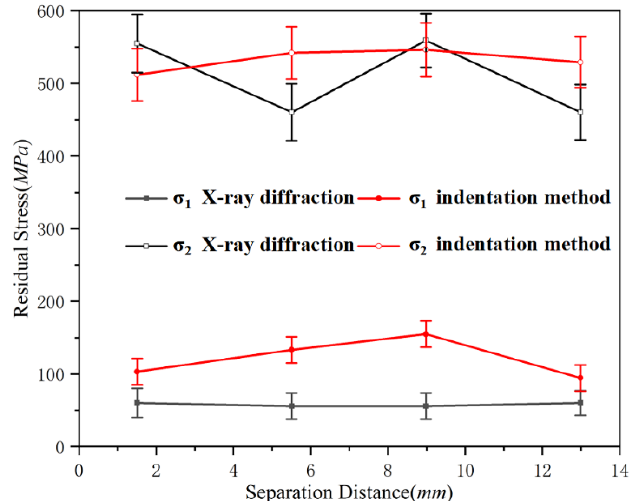
Figure 7. Measurement of Residual Stress in Inconel718 Weld Zone by X-ray Diffraction and the Indentation Method.